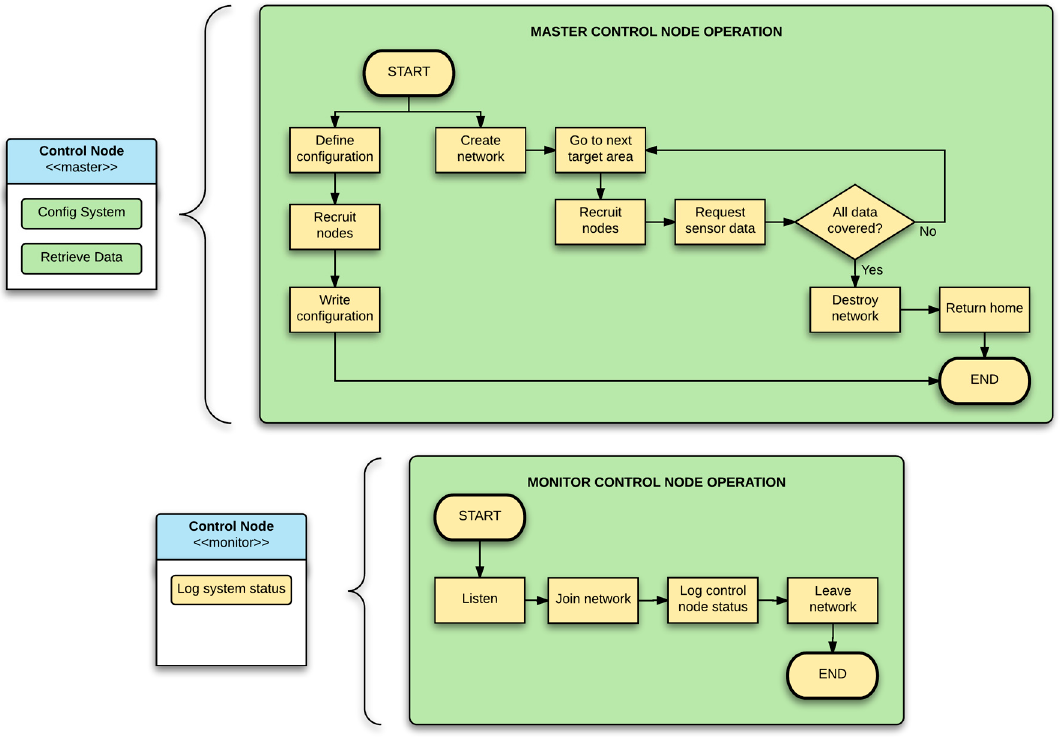
Figure 8. Control node’s task diagrams.